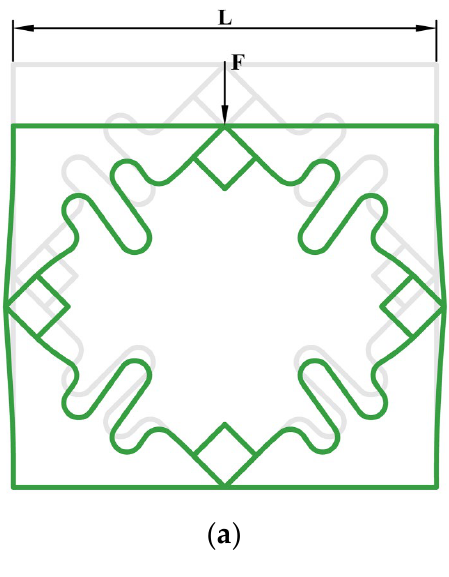
Figure 7. The deformation mechanism diagram and one of the geometric parameters of the compliant unit cell: ( a ) Deformation mechanism of the compliant cell under an external load; ( b ) Different S-shaped bulge heights of the compliant cell (L = 70 mm).